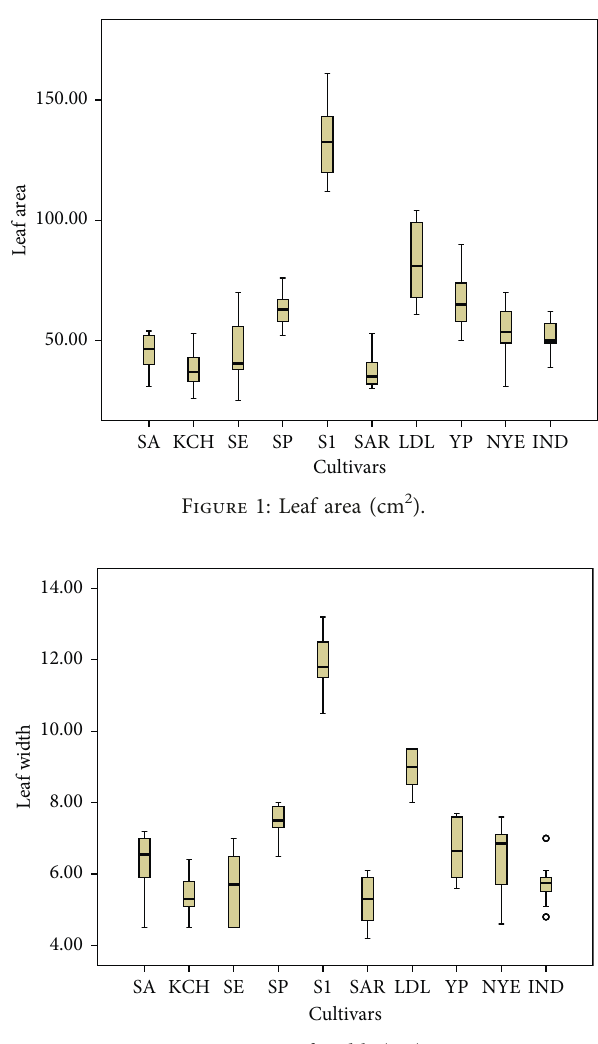
Figure 2: Leaf width (cm).